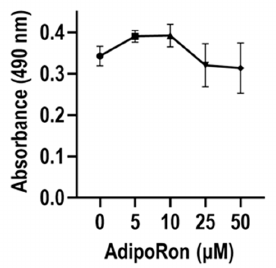
Figure 6. Dose optimization of the adiponectin receptor agonist AdipoRon by MTS assay. The results show that concentrations of up to 50 µM of AdipoRon do not statistically affect cell metabolism in MSCs derived from three distinct donors (211, 258 and 283). Line graphs show combined results for three biological replicates for each of the three donors (mean ± standard deviation). MSCs were then treated for two cycles with AdipoRon (25 µM) to assess effects on ADIPOQ receptor activation under basal and TGF β 1 conditions. Samples were analyzed by RT-qPCR assays to assess mRNA levels and by western blot analyses to define protein levels. MSCs treated with